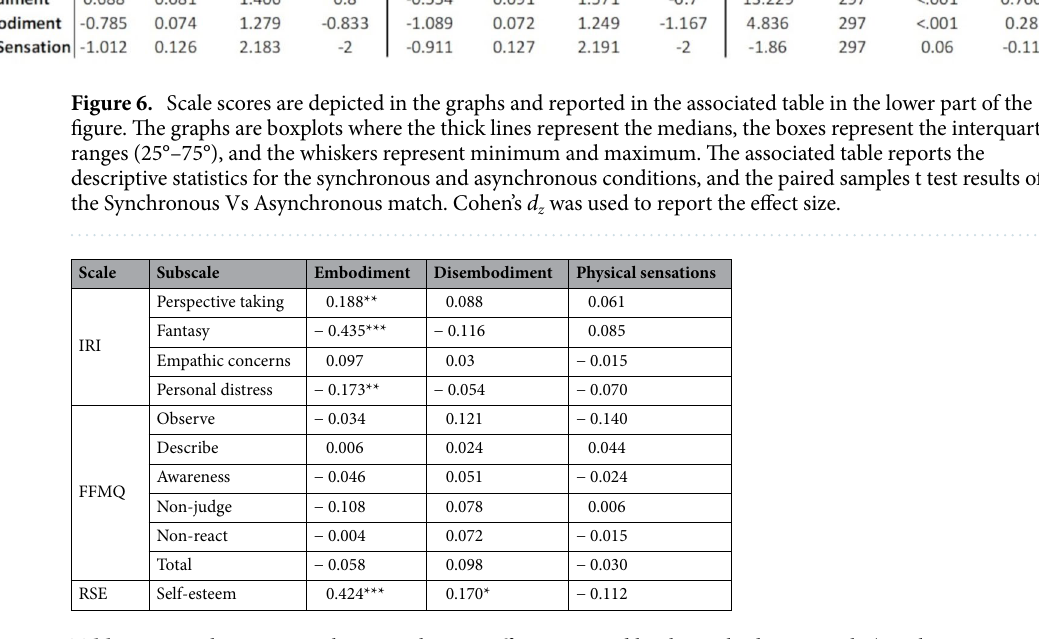
Table 4. Correlation matrix between the RHI effect measured by the Embodiment Scale (synchronous– asynchronous) and the personality traits. *p value < 0.05; **p value < 0.01; ***p value < 0.001.